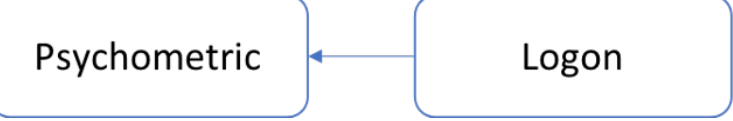
Figure 3. Demonstration of a